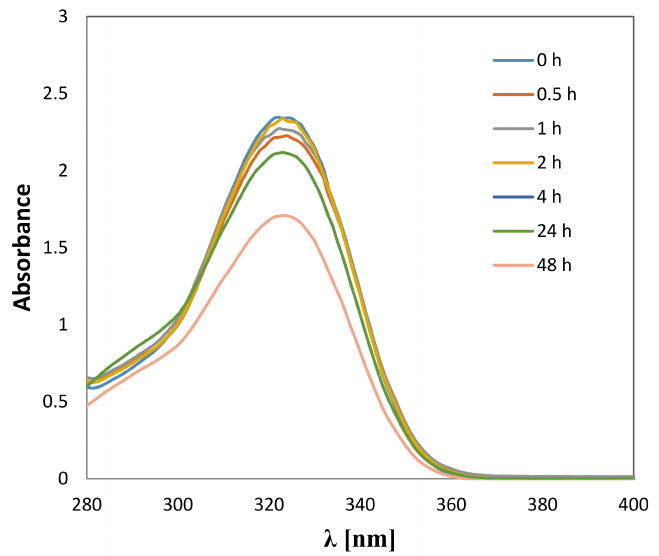
Figure 7. UV-vis absorbance spectrum of vitamin B6 and carboplatin mixture in an incubation